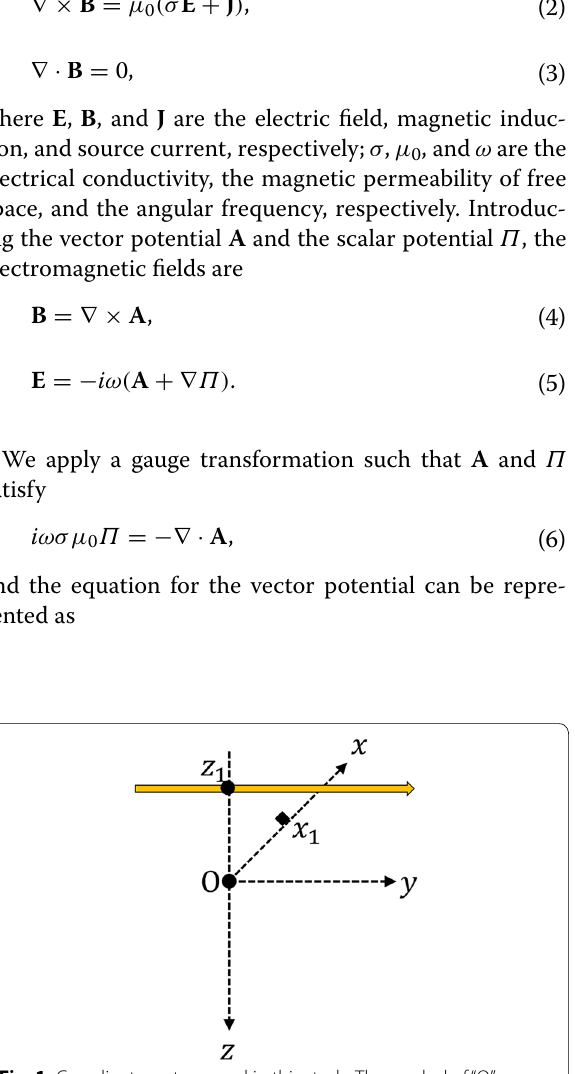
and diamond symbols mark the origin and an observation site, respectively; z 1 and x 1 are the altitude of the line source current and the horizontal distance of an observed site,